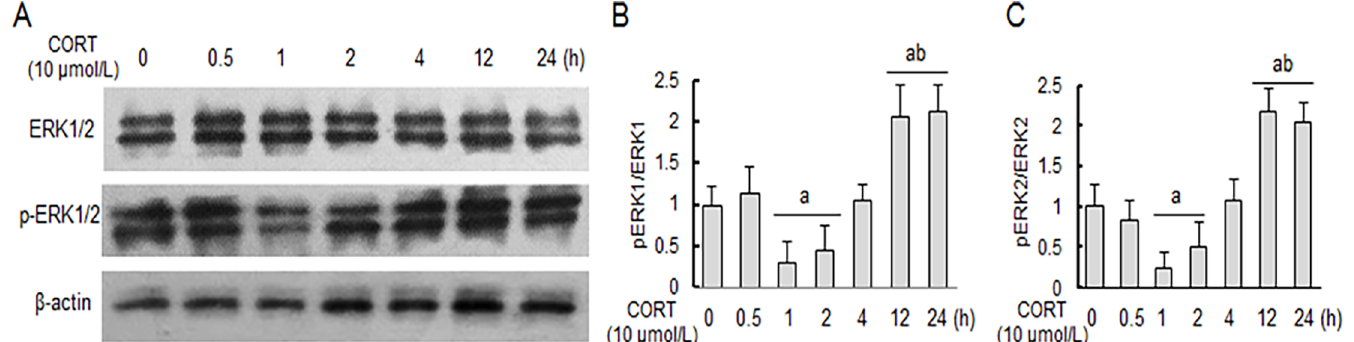
Fig 4. Corticosterone induces dynamic changes of ERK1/2 phosphorylation in primary hippocampal neuron cultures. Primary hippocampal neuron cultures were stimulated with CORT for indicated time period, and the cellular levels of total and phosphorylated ERK1/2 were determined by western blot analysis with reference to a house-keeping protein ( β -actin) as loading control. The specific signals were visualized with “ChemiDoc XRS” digital imaging system, and a representative western blot was shown (A). The relative protein levels were expressed as the relative band density of the corresponding protein (B, C). a P < 0.05 vs normal control group: b P < 0.05 vs CORT treatment 2 h group.